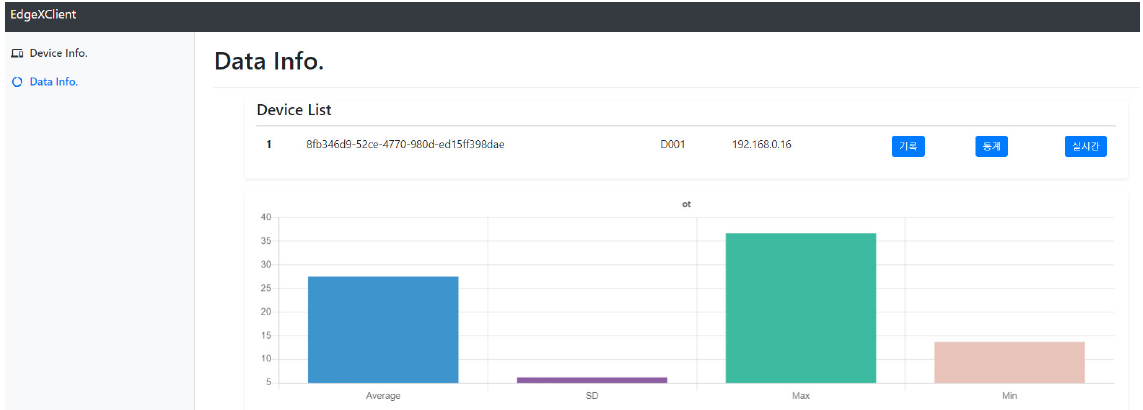
Figure 15. The Implemented Result of Static Data of Client Services.